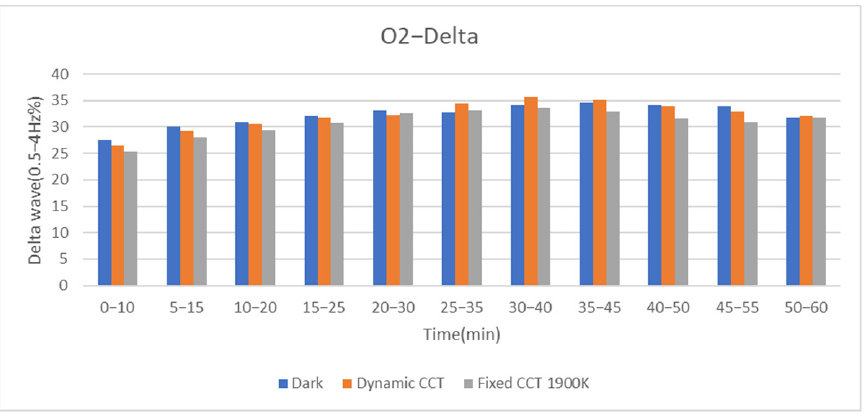
Figure 23. O2 δ wave analysis. According to the analysis of the total energy results of theta and delta of O1 and O2, O1_Theta and O2_Delta show statistical differences. O1_Theta electroencephalogram energy has a fixed color temperature of 1900 K higher than the dynamic color temperature and higher than the non-light environment, and O2_Delta electroencephalogram energy has a non-light value higher than the dynamic color temperature and higher than the fixed color temperature of 1900 K. However, a fixed color temperature of 1900 K can only relax, and there is no way to assist in deep sleep in delta energy, while dynamic light and no light can make the brain generate more delta energy, and the delta energy intensity of dynamic light and no light is also closer, as shown in Figure